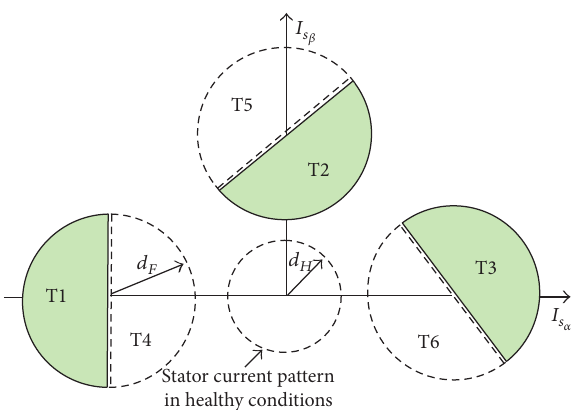
Figure 2: Current patterns in healthy and faulty modes.